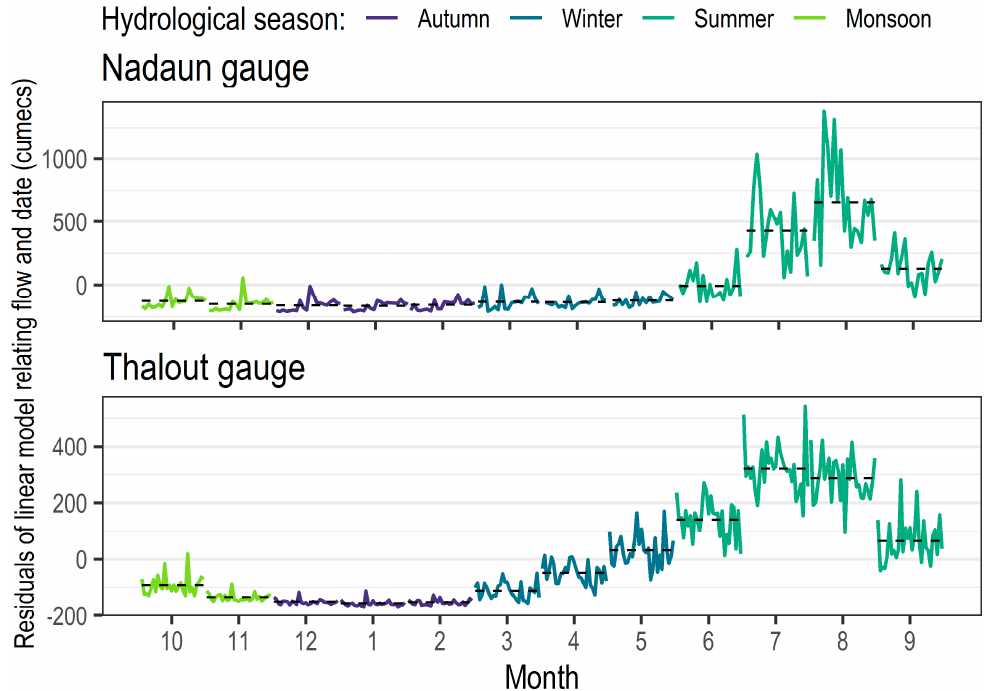
Figure A1. Seasonal subseries plots for the two gauging stations in the case study catchment.